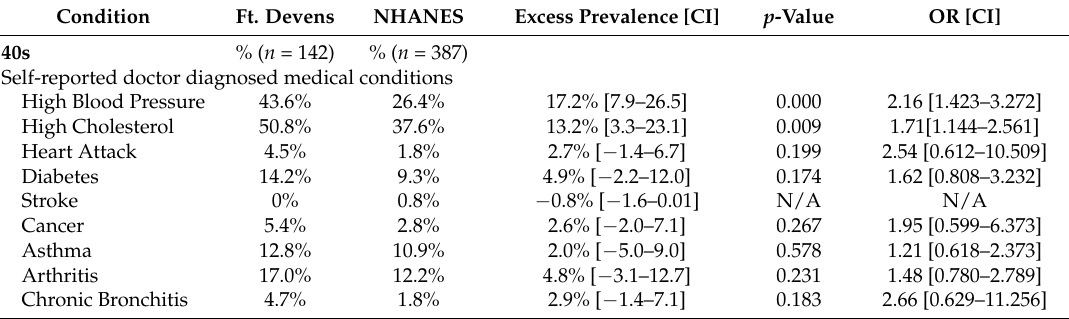
Figure 1. Prevalence of medical conditions in male and female participants from FDC and NHANES cohorts in the restricted sample. (Error bars represent Standard Error). Table 3. Cohort comparison of male rates of medical conditions by age group.